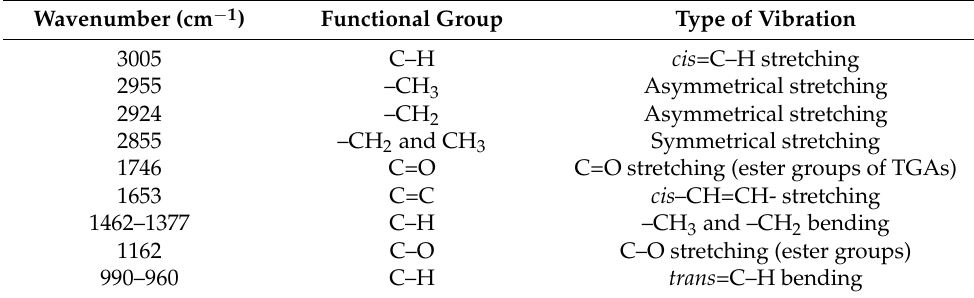
Table 5. Main MIR absorption band assignments for extra-virgin olive oil [108,111].